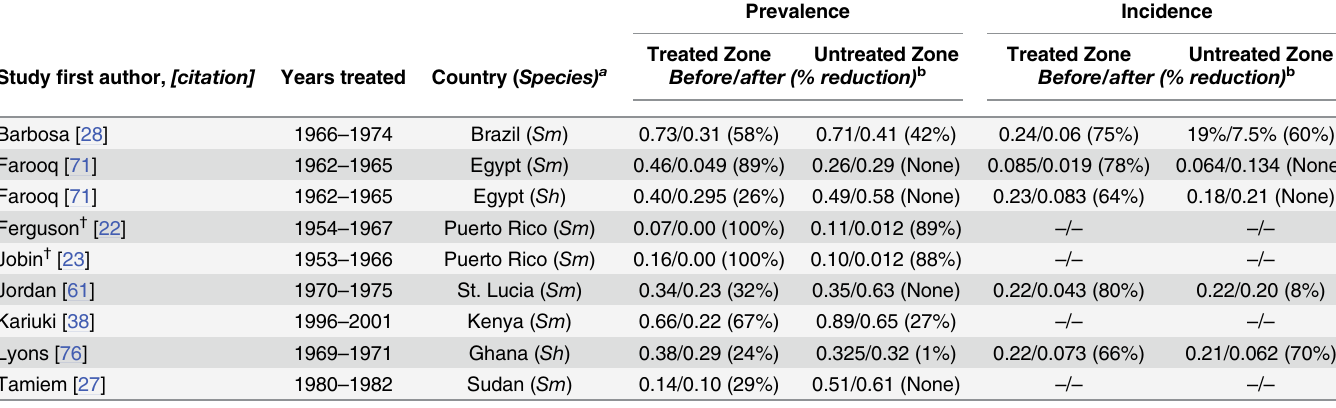
Table 1. Impact of mollusciciding on Schistosoma infection compared concurrently to transmission in untreated control areas. Prevalence Incidence Treated Zone Untreated Zone Treated